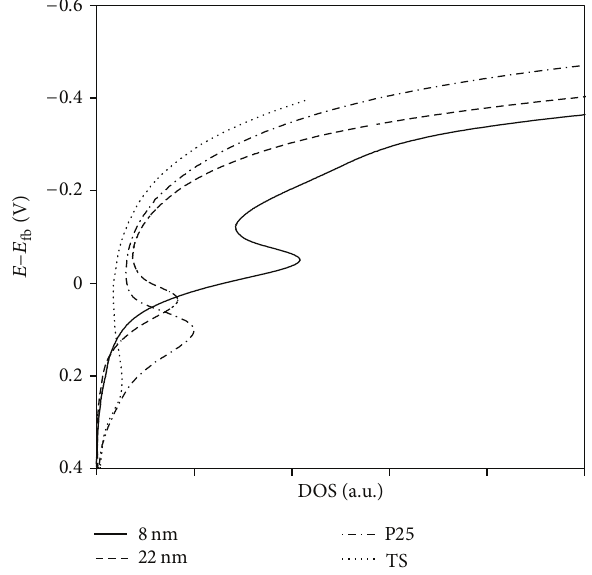
Figure 6: Density of states calculated using (6) with the layer thickness constant equal to 3 nm, which is the thickness of the naturally formed film. The relative DOS values are affected by the thickness of the